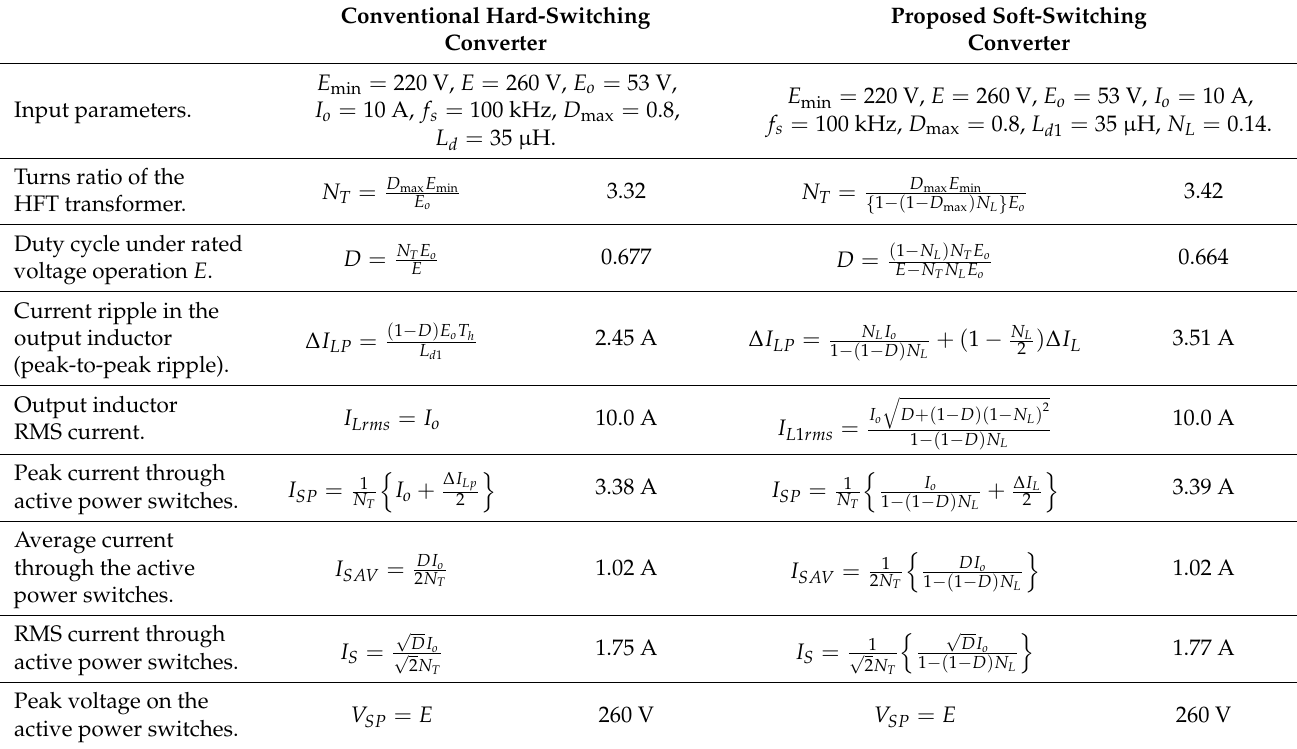
Table 2. Comparison of voltage and current stresses of the proposed and conventional converter. Conventional Hard-Switching Converter